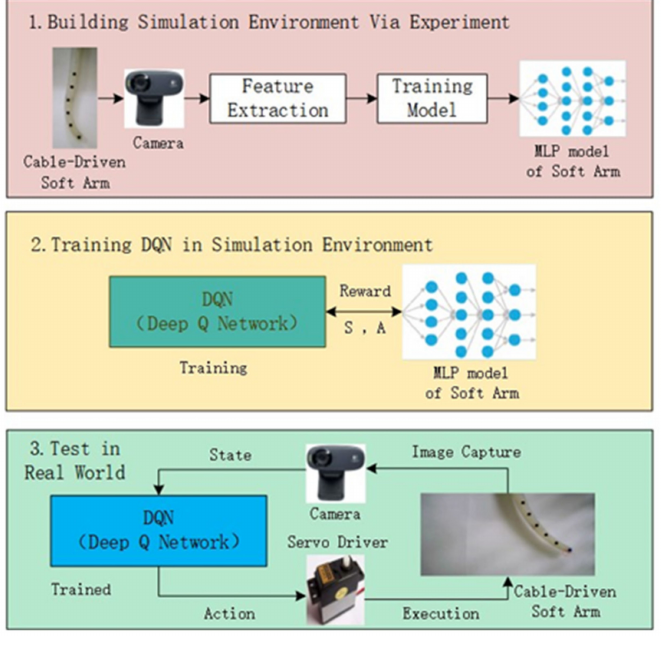
Figure 2. System